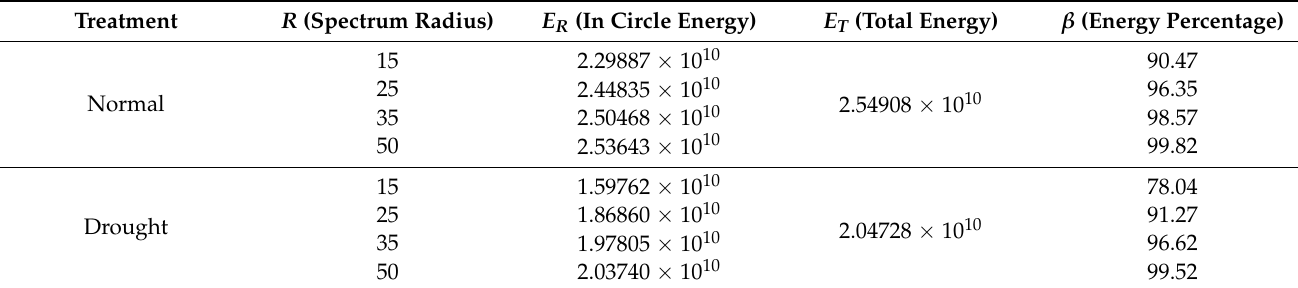
Table 4. Spectrum energy distribution of the soybean canopy in the green channel.